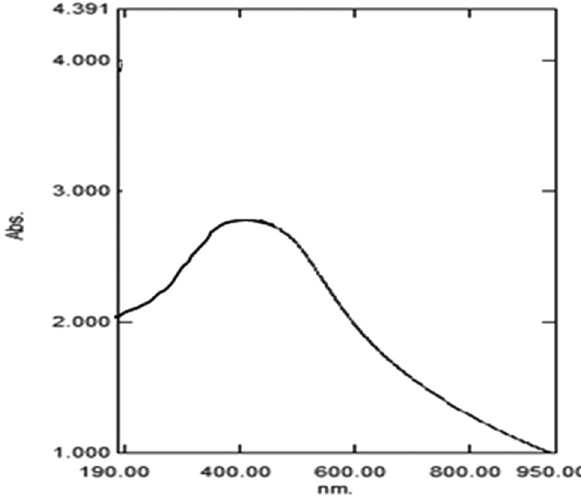
Figure 2: UV - Vis spectra of Ag - NPs produced by A. vera extract.